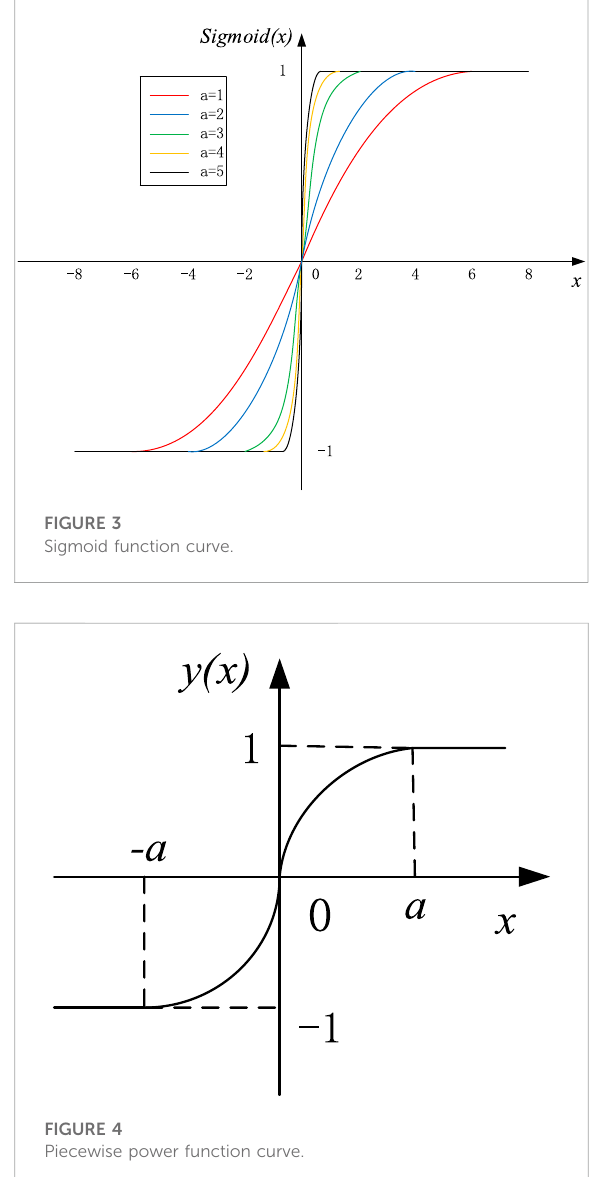
FIGURE 4 Piecewise power function